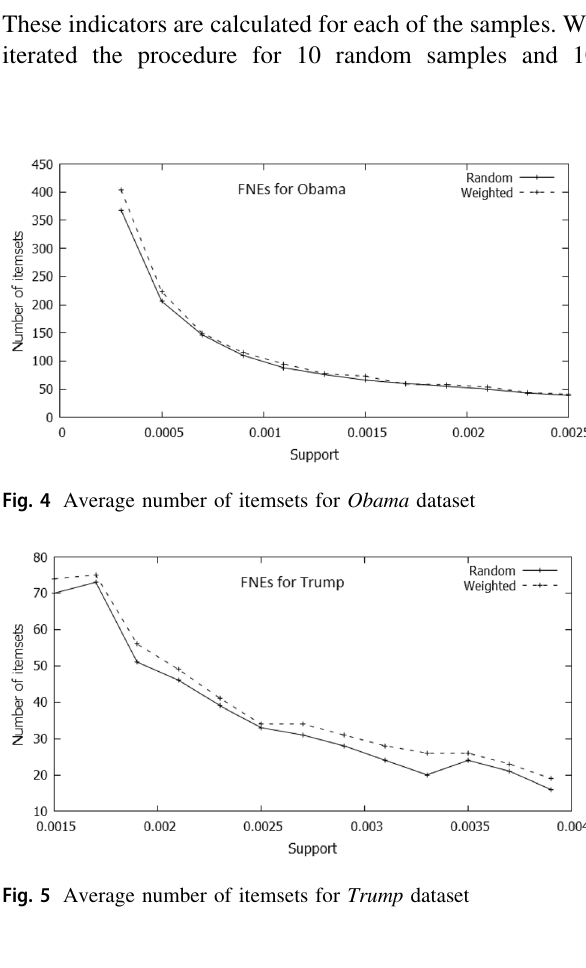
Table 3 Average indicators of the samples